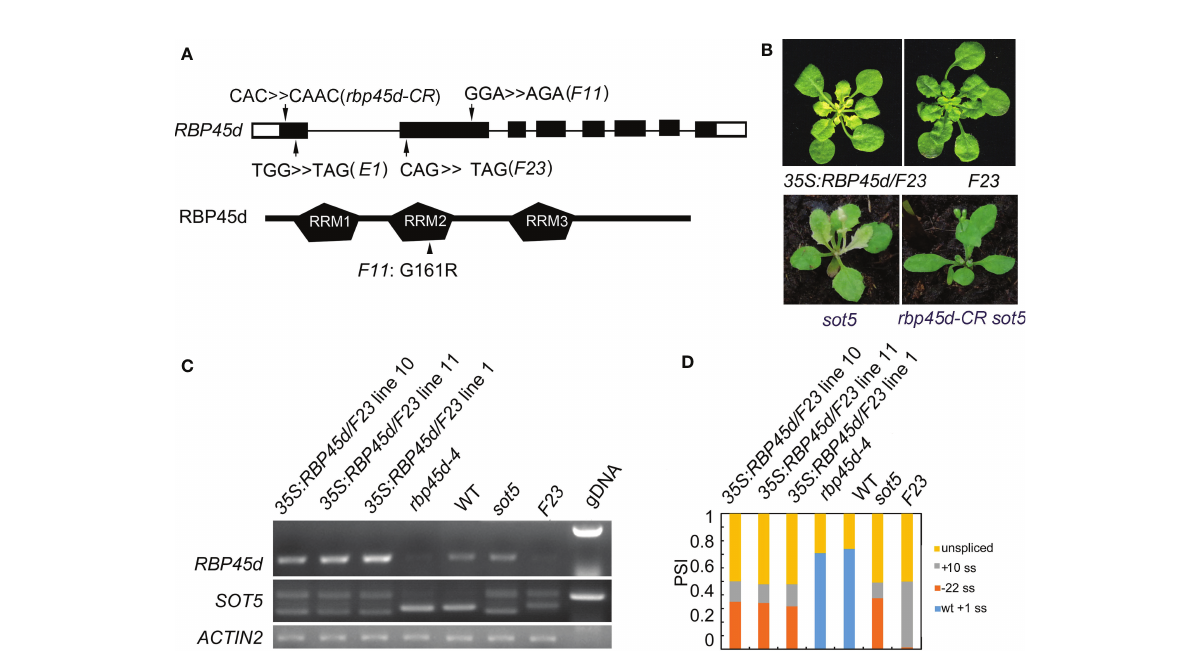
FIGURE 2 Mutations in RBP45d suppress the sot5 phenotype. (A) Schematic diagrams of RBP45d gene structure and RBP45d protein with the three RRM domains. Arrows indicate the mutation sites in E1 , F23 and F11 lines. The upper case letters indicate the mutated genetic codon(s) in E1 and F23 which become the stop codons, and that in F11 which leads to replacement of the amino acid residue from G to R in the conservative region of the RRM2 domain (arrowhead). The black boxes indicate exons in UTR and the black rectangles indicate exons in CDS and the black lines indicate introns. (B) Overexpression of RBP45d CDS in F23 restores the phenotype. And the rbp45d-CR sot5 double mutant showed the WT-like phenotype. One of representative 35S:RBP45d/F23 line was shown. (C) RT-PCR analysis of RBP45d expression and the splicing products of SOT5 intron 7 in three 35S:RBP45d/F23 transgenic lines, rbp45d-4 , WT, sot5 , and F23 plants. ACTIN2 was used as an internal control and gDNA is used as a control. Two biological replicates (independent pools of aerial parts of plants) were analyzed, and one representative result is shown. (D) Quanti fi cation of the splicing variants from SOT5 intron 7 shown in (C) . PSI (percent spliced in index) indicates the percentage of each variant in total